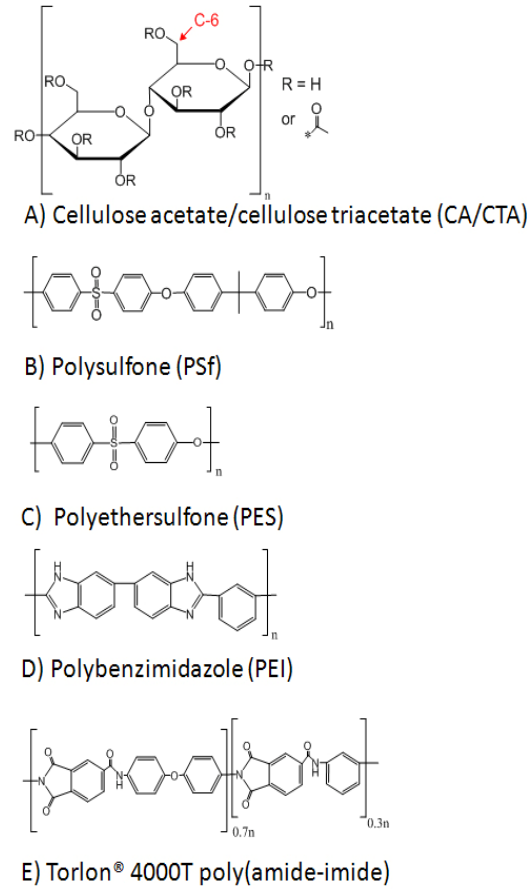
Figure 7. ( A ) The chemical structure of cellulose acetate (the red text marks the exocyclic C-6 carbon in one of the rings); ( B ) the chemical structure of polysulfone; ( C ) the chemical structure of polyethersulfone; ( D ) the chemical structure of polybenzimidazole and ( E ) the proposed structure of Torlon ® 4000T poly(amide-imide)